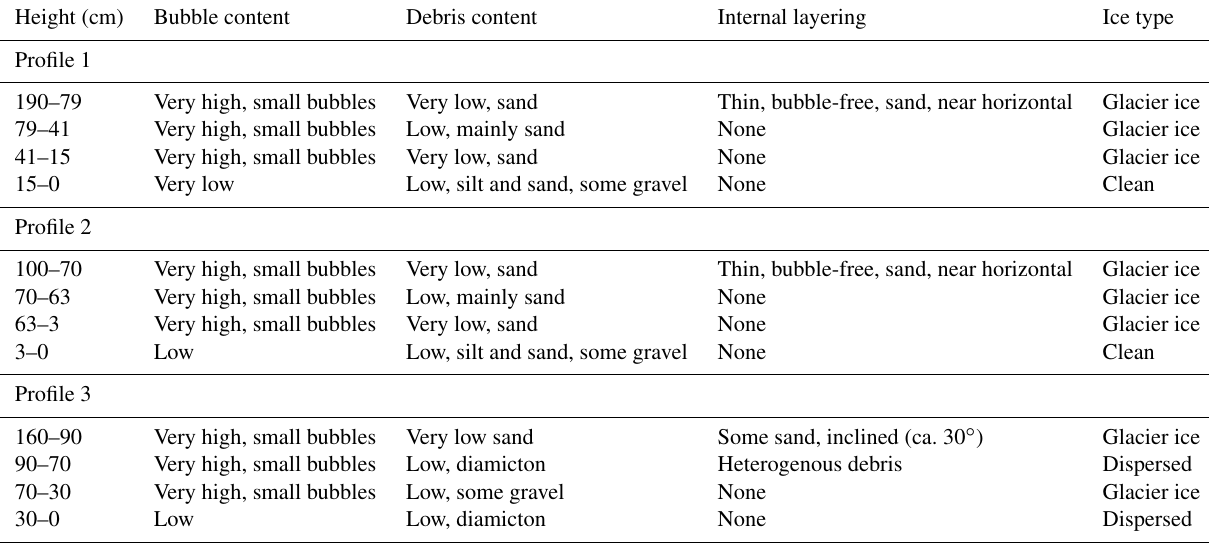
Table 2. Macroscopic characteristics of the ice facies at the locations of the three profiles in the ice tunnel at Chli Titlis. The facies/ice type classification is based on the scheme of Hubbard et al. (2009). Height refers to the distance above bedrock.